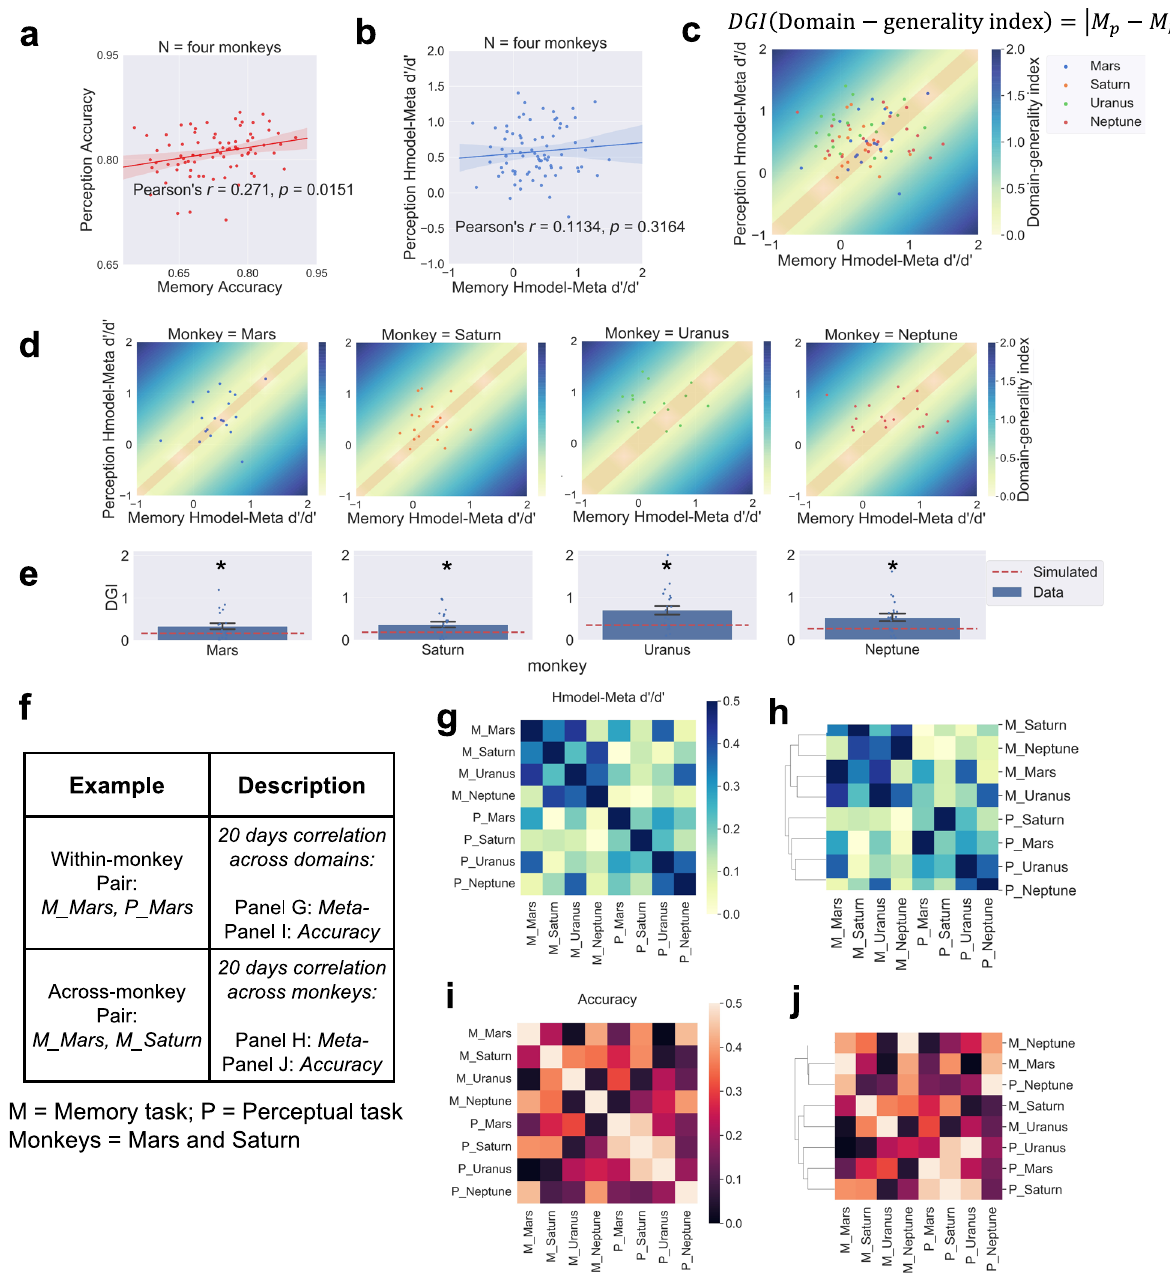
Fig. 6 Domain-speci fi c metacognition in monkeys. Task performance in terms of percentage correct was correlated across perceptual and memory domains ( a ). In contrast, their metacognitive ef fi ciency was not correlated across perceptual and memory domains ( b ). The DGI quanti fi es the similarity between their metacognitive ef fi ciency scores in each domain. Greater DGI scores indicate less metacognitive consistency across domains. Darker colours indicate lower metacognitive generality across domains, and the red area indicates the simulated DGI values. The daily domain-generality index (DGI) is shown for each monkey ( c ) and for all four monkeys ( d ). The monkeys demonstrate a greater DGI than shuf fl ed data (chance) ( e ). Two example pairs for pairwise correlation analysis are described ( f ). The pairwise correlation matrix indicate a pairwise correlation between each monkey and each domain in Hmodel- meta d ′ /d ′ ( g ) and in accuracy ( i ). Cluster results from the pairwise correlation matrix in Hmodel- meta d ′ /d ′ , revealing two distinct clusters in which data from the same domain grouped together ( h ), but not in accuracy ( j ). Error bars indicate ± one standard error; * indicates p < 0.05. Shaded areas indicate bootstrap-estimated 95% con fi dence intervals for the regression